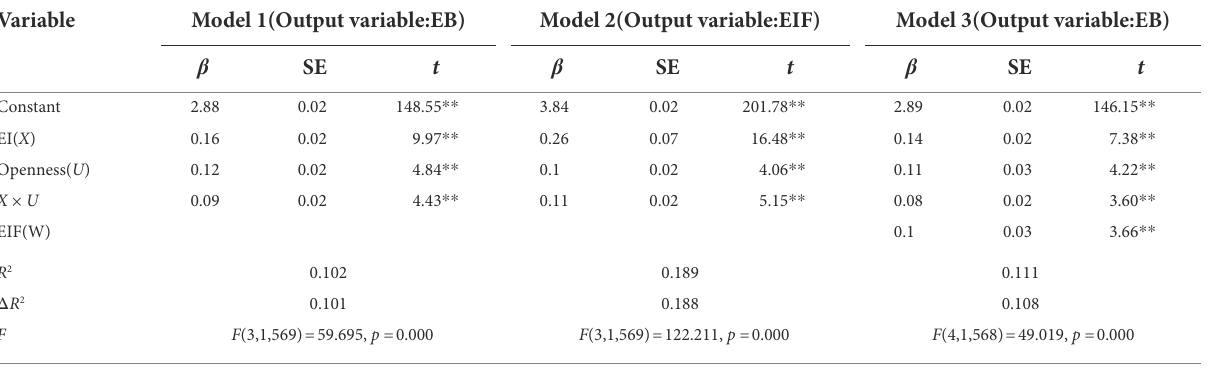
TABLE 4 Test of mediated moderating